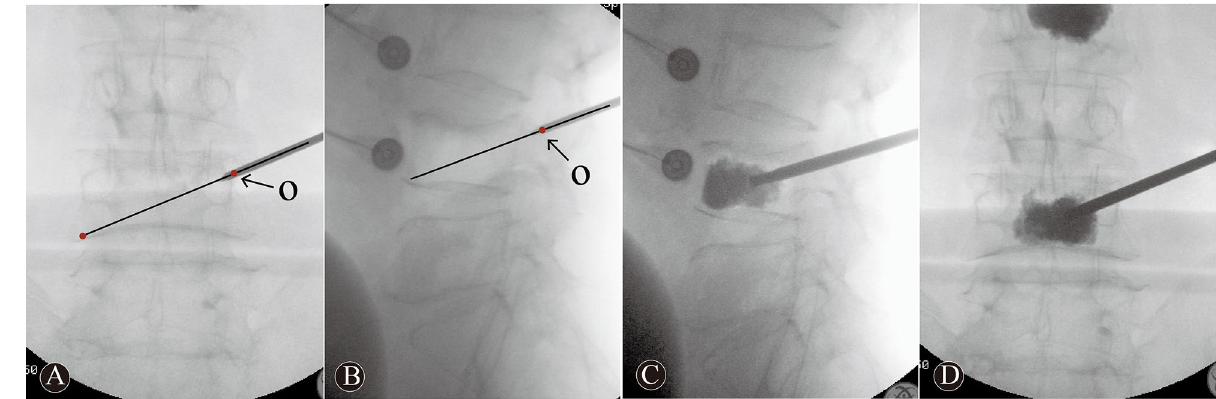
Figure 2. A 68 years-old woman in O-PKP group with L1, L2 and L4 OVCFs. These intraoperative images demonstrate operation techniques and procedures. The needle via point “O” to the contralateral inferior corner of vertebral body on posteroanterior imaging ( A ). The entry point “O” is located at the intersection of the posterior-superior margin of the pedicle and lateral margin to superior articular process on lateral imaging ( B ). These images ( C , D ) demonstrate an ideal bone cement distribution, the bone cement across the anterior one-third midline and across the midline of the vertebral body.